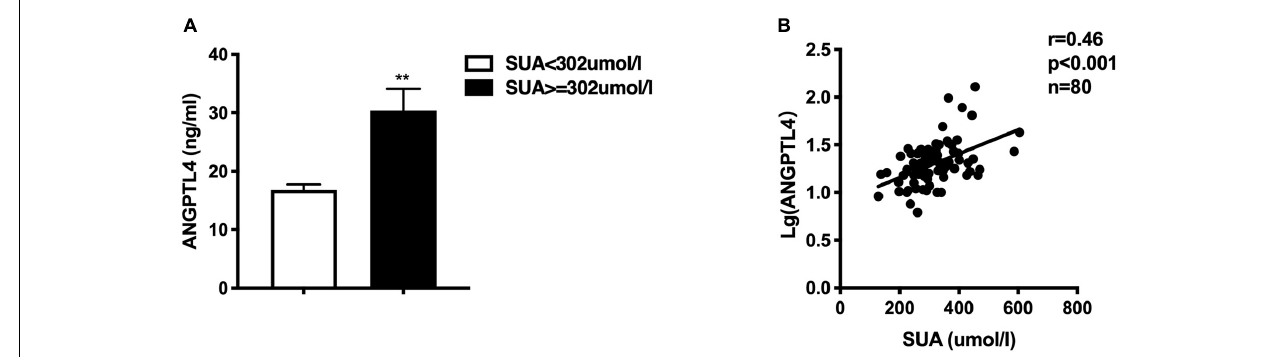
FIGURE 3 | (A) Comparison of circulating ANGPTL4 between high SUA group and low SUA group, the Mann-Whitney U -test showed that serum ANGPTL4 was significantly greater in the high SUA group than in the low SUA group, ** p < 0.01. (B) Serum uric acid is positively correlated to ANGPTL4 concentration in all subjects.